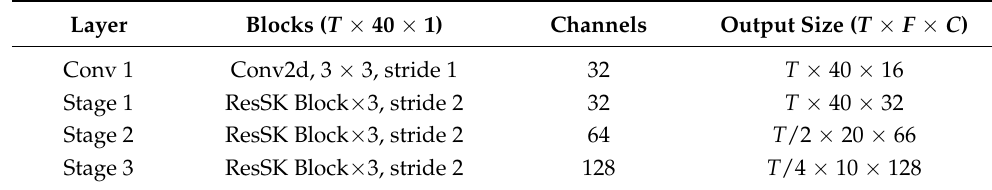
Figure 1. Overview of the ResSKNet-SSDP speaker recognition system. Table 1. The structure of ResSKNet.